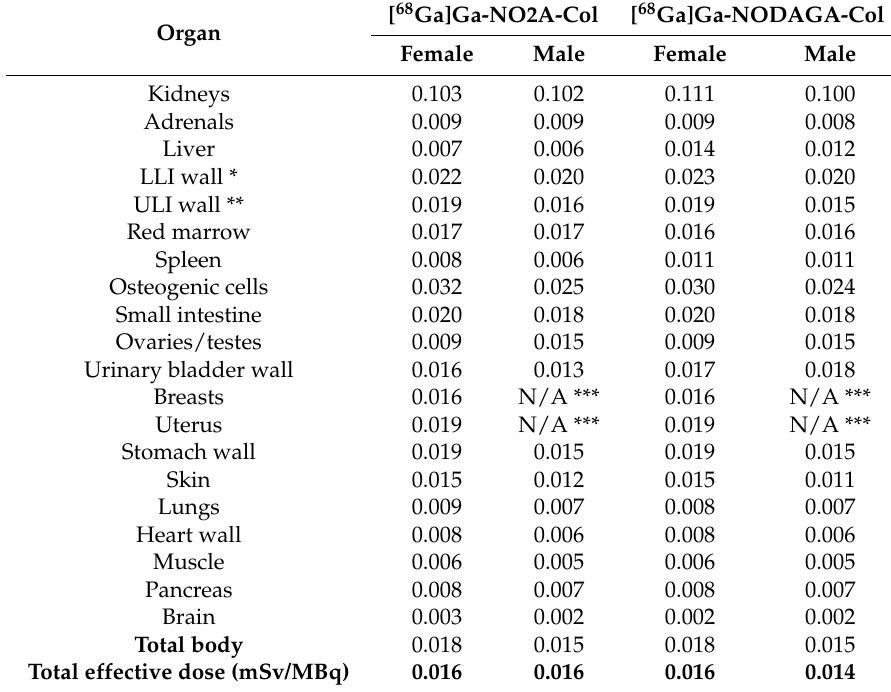
Table 2. Estimated absorbed doses (mGy/MBq) of [ 68 Ga]Ga-NO2A-Col or [ 68 Ga]Ga-NODAGA-Col in human females and males extrapolated from rat organ distribution data.